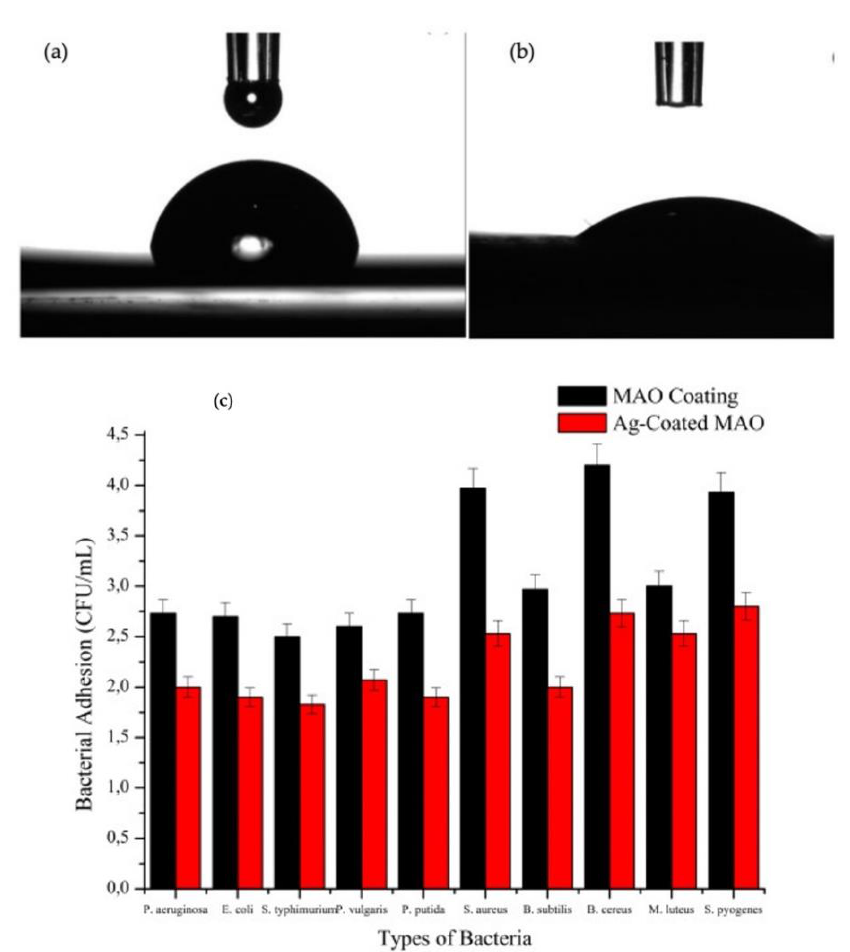
Figure 2. ( a , b ) The contact angle measurements: bare substrate and the PEO coating are displayed, respectively [29] (Reproduced with permission number: 5061321012937, Elsevier); ( c ) the plot for illustration of Gram-positive and Gram-negative bacteria’s adhesion on the surface of PEO and Ag-based PEO coatings from [37] (Reproduced with permission number: 5061400310129, Elsevier).